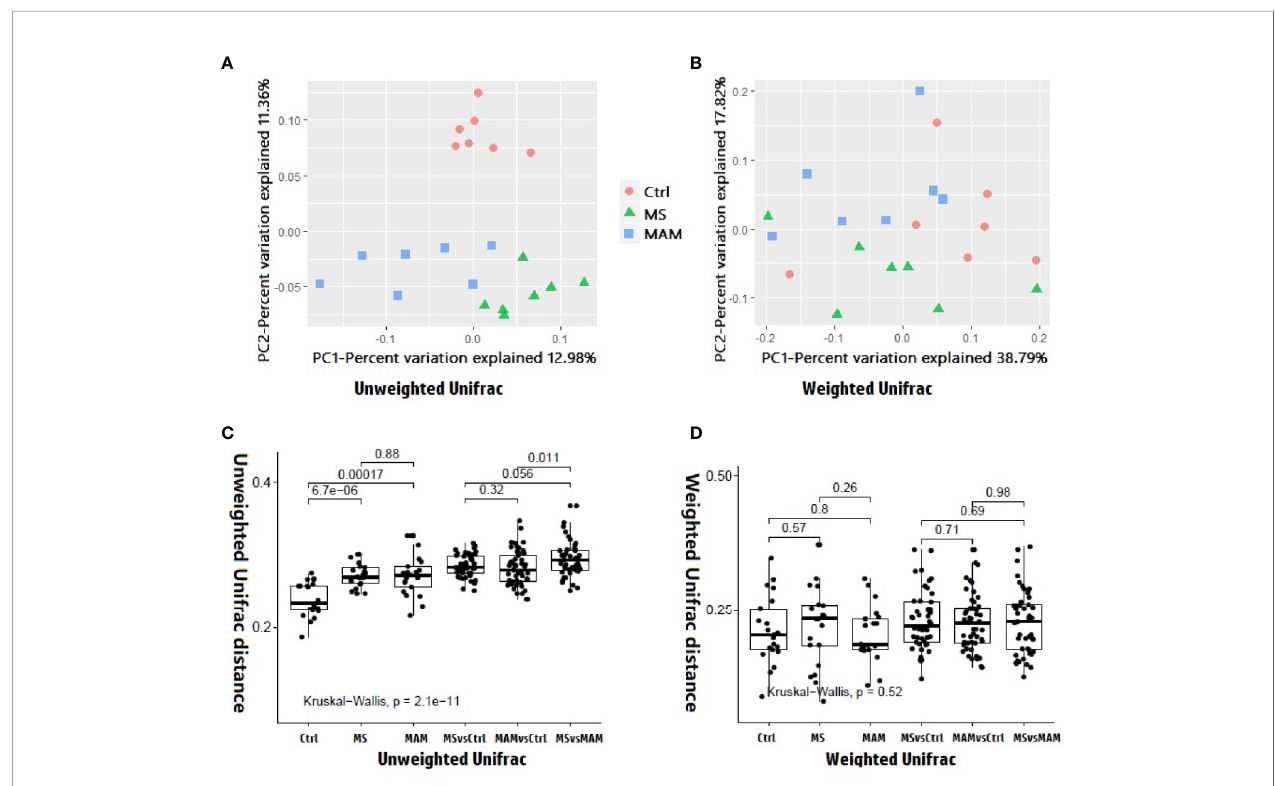
FIGURE 4 | Beta diversity analysis among and within different model groups. (A) 2D PCoA plots showing differences in the gut microbiota of rats from different model groups based on the unweighted Unifrac distance metric. p = 0.001and r 2 = 0.21127 in the Adonis test, p = 0.001 and adjusted r 2 = 0.123634 in db-RDA analysis. (B) 2D PCoA plots showing differences in the gut microbiota of rats from different model groups based on the weighted Unifrac distance metric. p = 0.047 and r 2 = 0.1743 in the Adonis test. p = 0.048 and adjusted r 2 = 0.069004 in db-RDA analysis. (C) Comparison of inter-individual variation between and within different model groups based on the unweighted Unifrac distance metric. (D) Comparison of inter-individual variation between and within different model groups based on the weighted Unifrac distance metric.